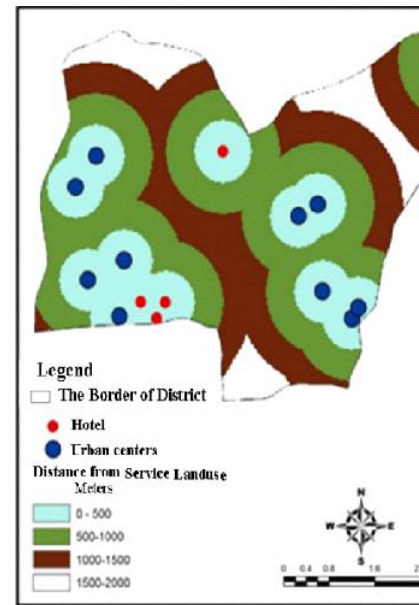
Fig. 11: The distance from Therapy centers